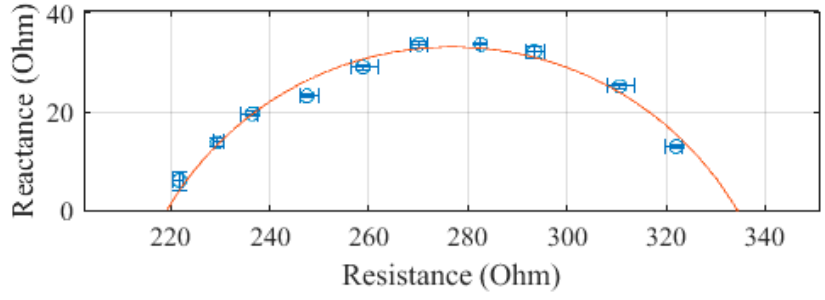
Figure 5. Cole–Cole plot of the arm impedance of subject 1 measured with the SBISD.